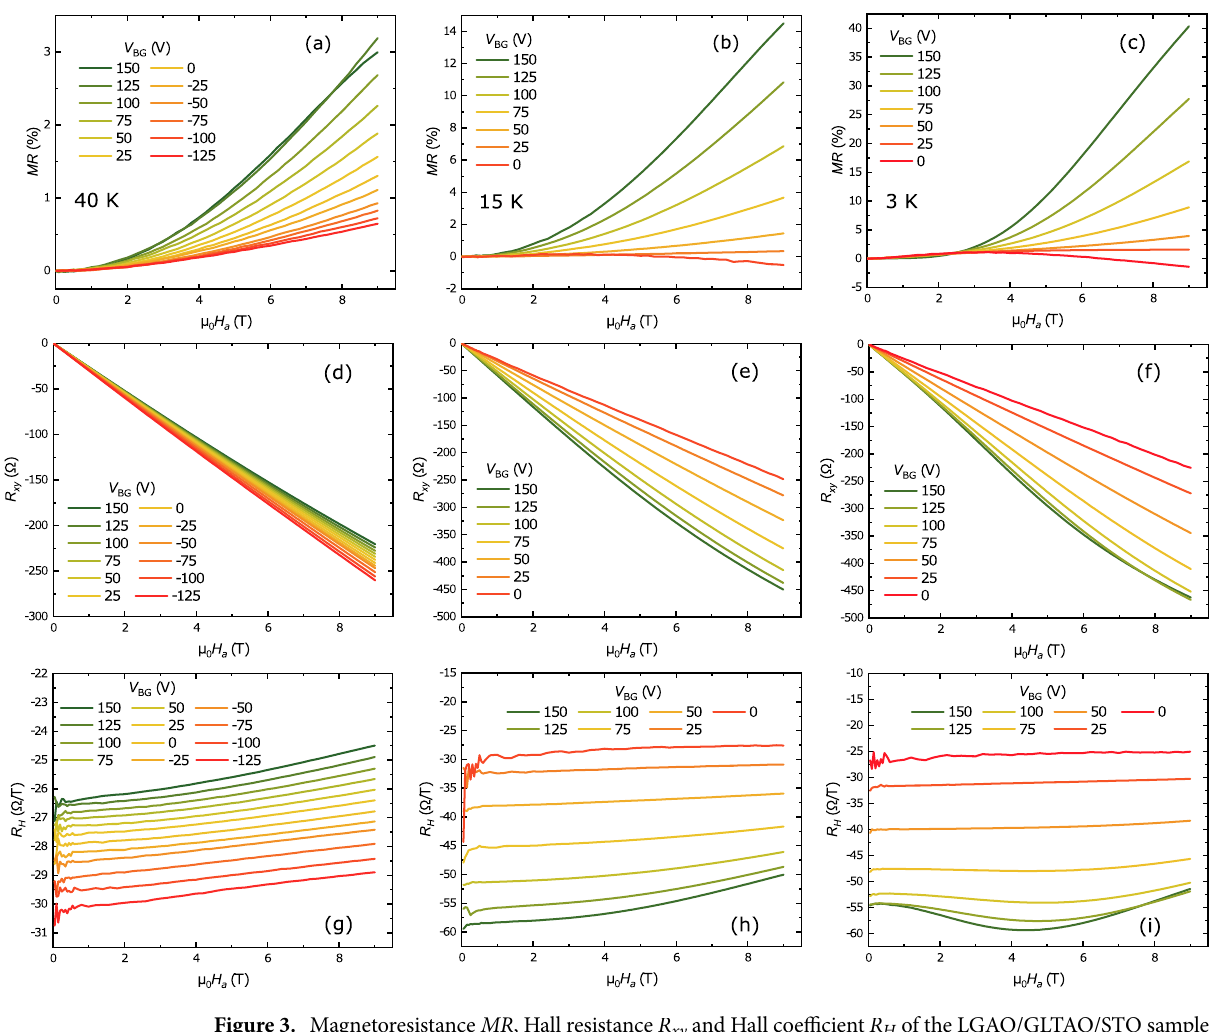
Figure 3. Magnetoresistance MR , Hall resistance R xy and Hall coefficient R H of the LGAO/GLTAO/STO sample for different positive back gate voltages V BG as indicated at the temperatures of 40 K (a,d,g) , 15 K (b,e,h) and 3 K (c,f,i) .